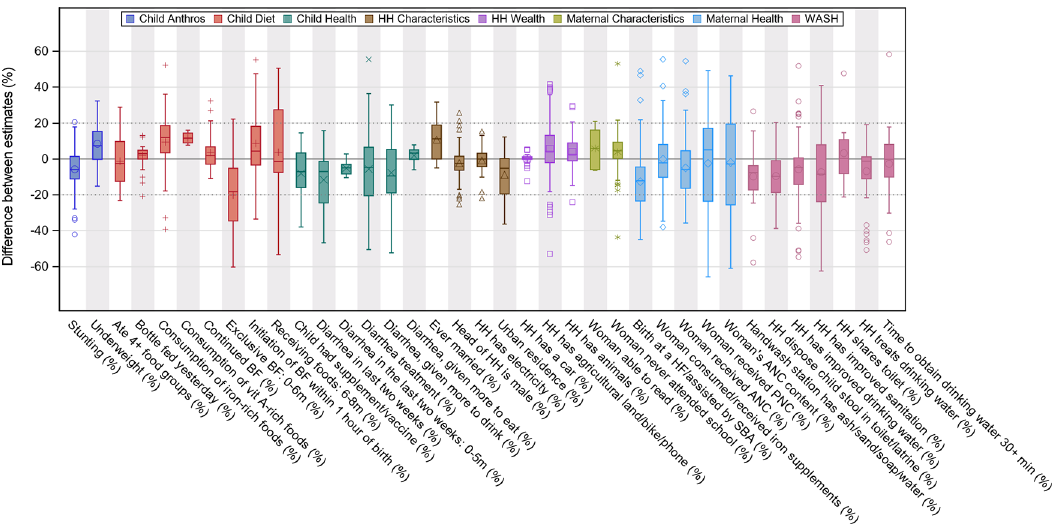
Figure 2. Difference between estimates (DHS/MICS minus NGO) by subgroup of indicators. Abbreviations: Anthros: anthropometry indicators; HH: household; WASH: Water, Sanitation, and Hygiene; BF: breastfeeding; HF: health facility; SBA: skilled birth attendant; ANC: antenatal care; PNC: postnatal care; DHS: Demographic and Health Surveys; MICS: Multiple Indicator Cluster Surveys; NGO: non-governmental